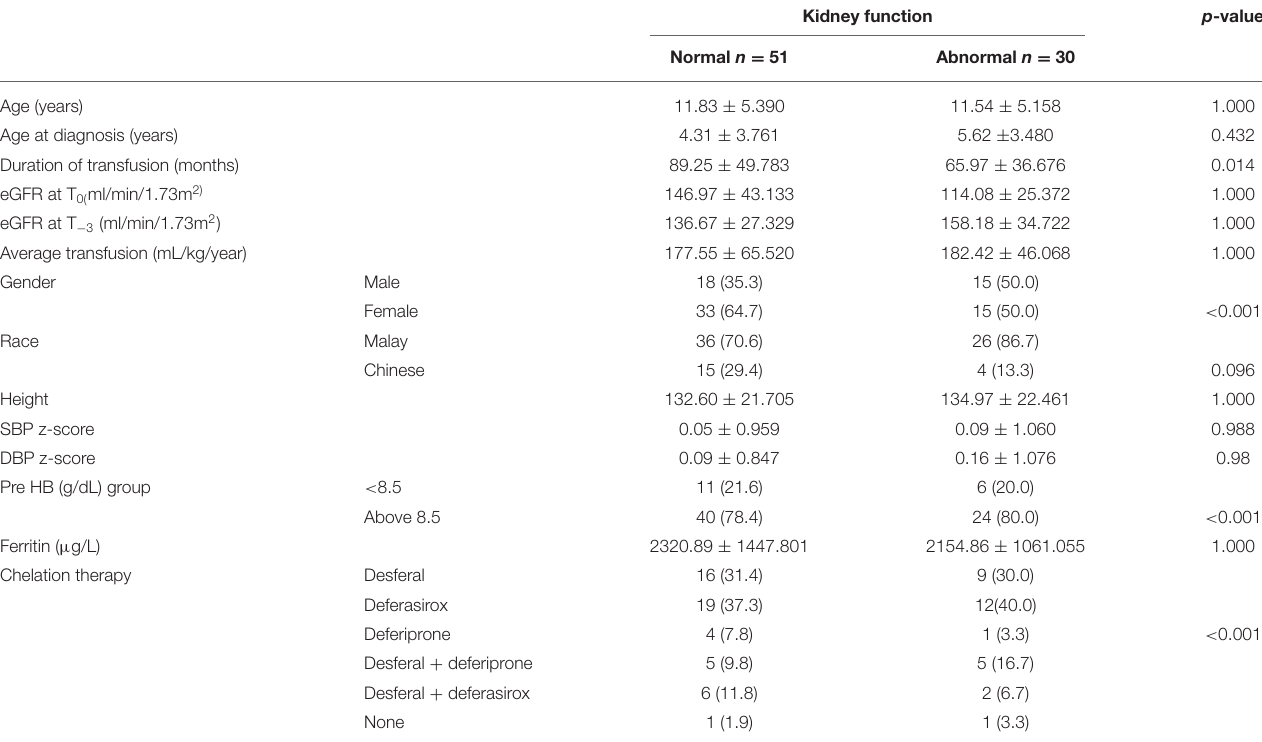
TABLE 1 | Basic characteristics among normal and abnormal kidney function patients.